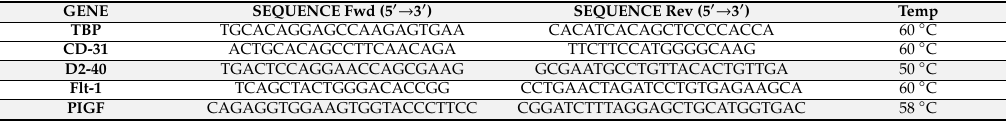
Table 1. RT-qPCR primer sequences and temperature (Temp). PIGF, placental growth